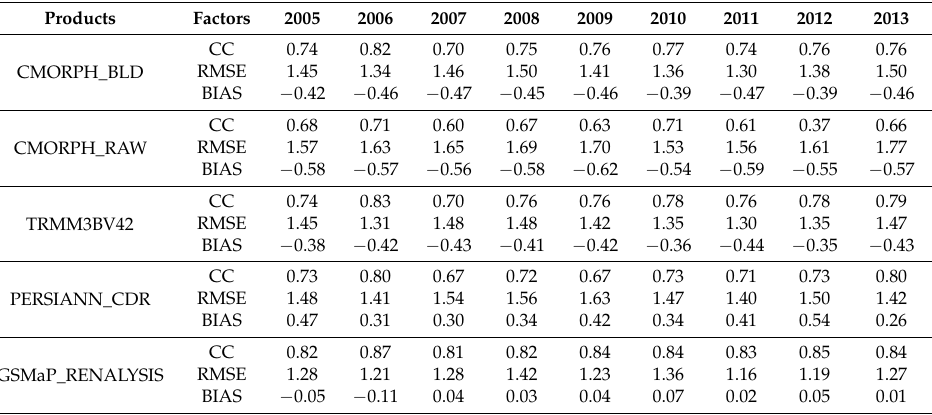
Table 3. The CC, BIAS and RMSE values for a variety products and the gauge station data for a year of the daily mean precipitation values over